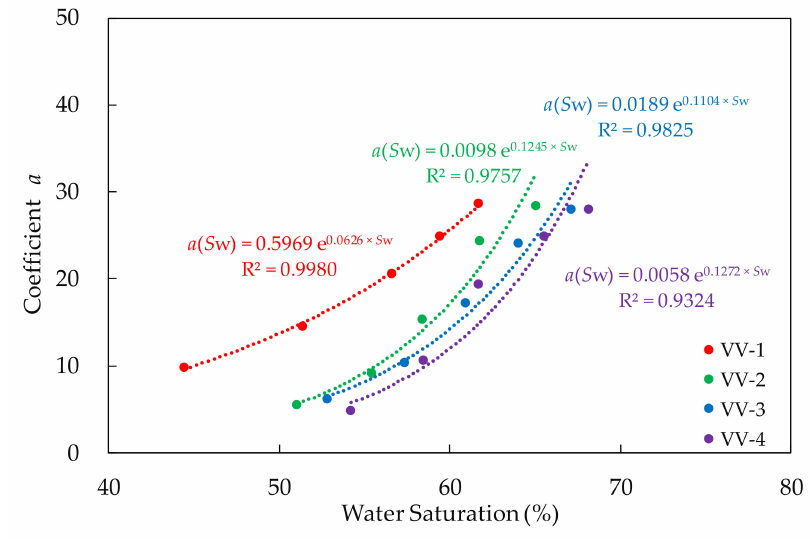
Figure 7. The relationship between the coefficient a in Formula (7) and water saturation.